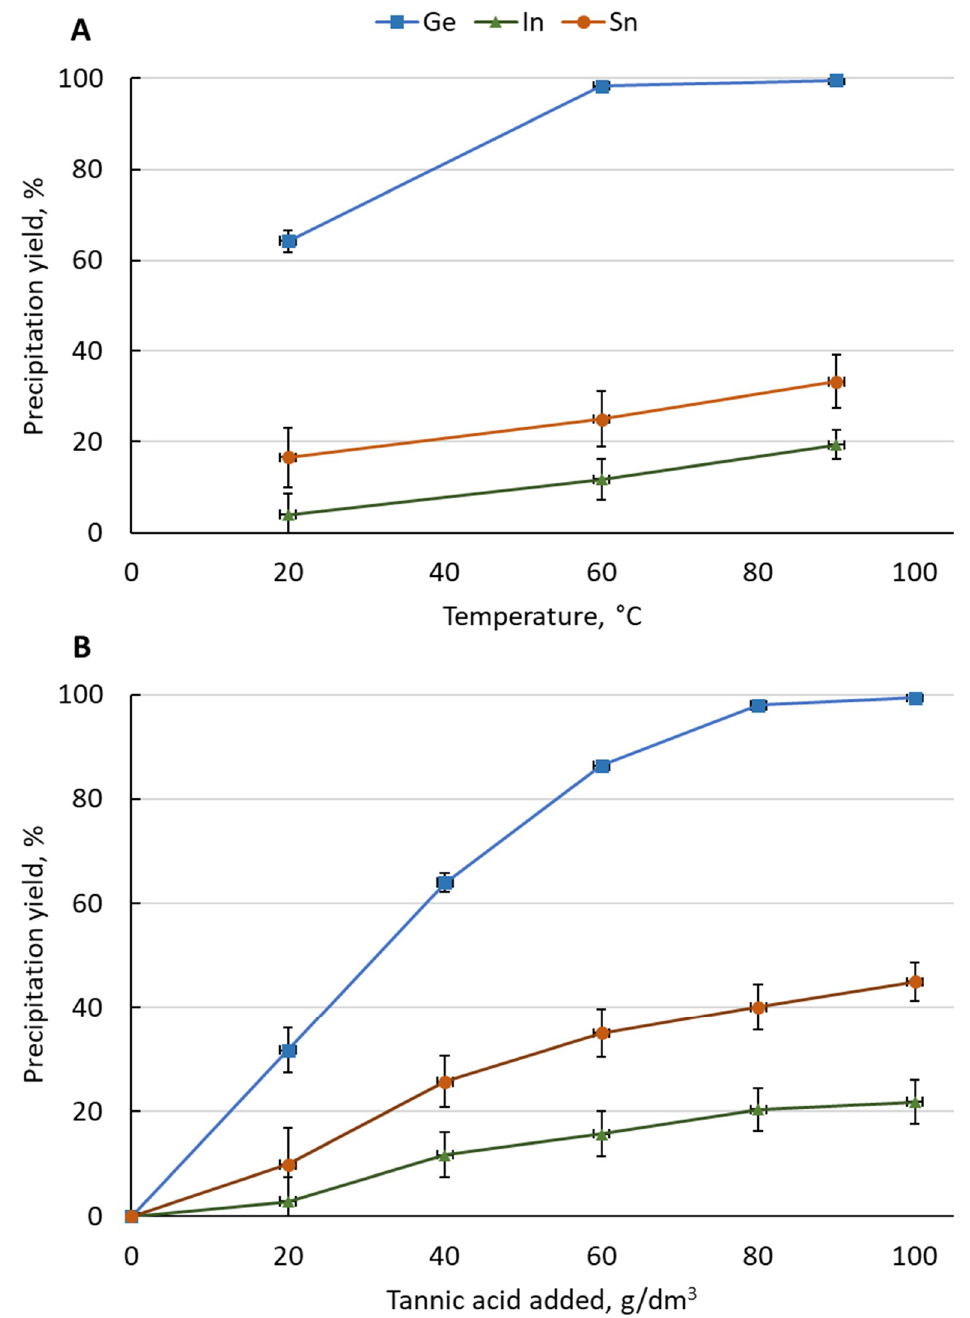
Figure 1. Influence of ( A ) temperature and ( B ) tannic acid amount on precipitation yield of Ge, In, and Sn from the solution ((A)—2 h, 100 g/dm 3 pure tannic acid, 1 portion; (B)—90 °C, pure tannic acid added in portions, 1 h between portions).